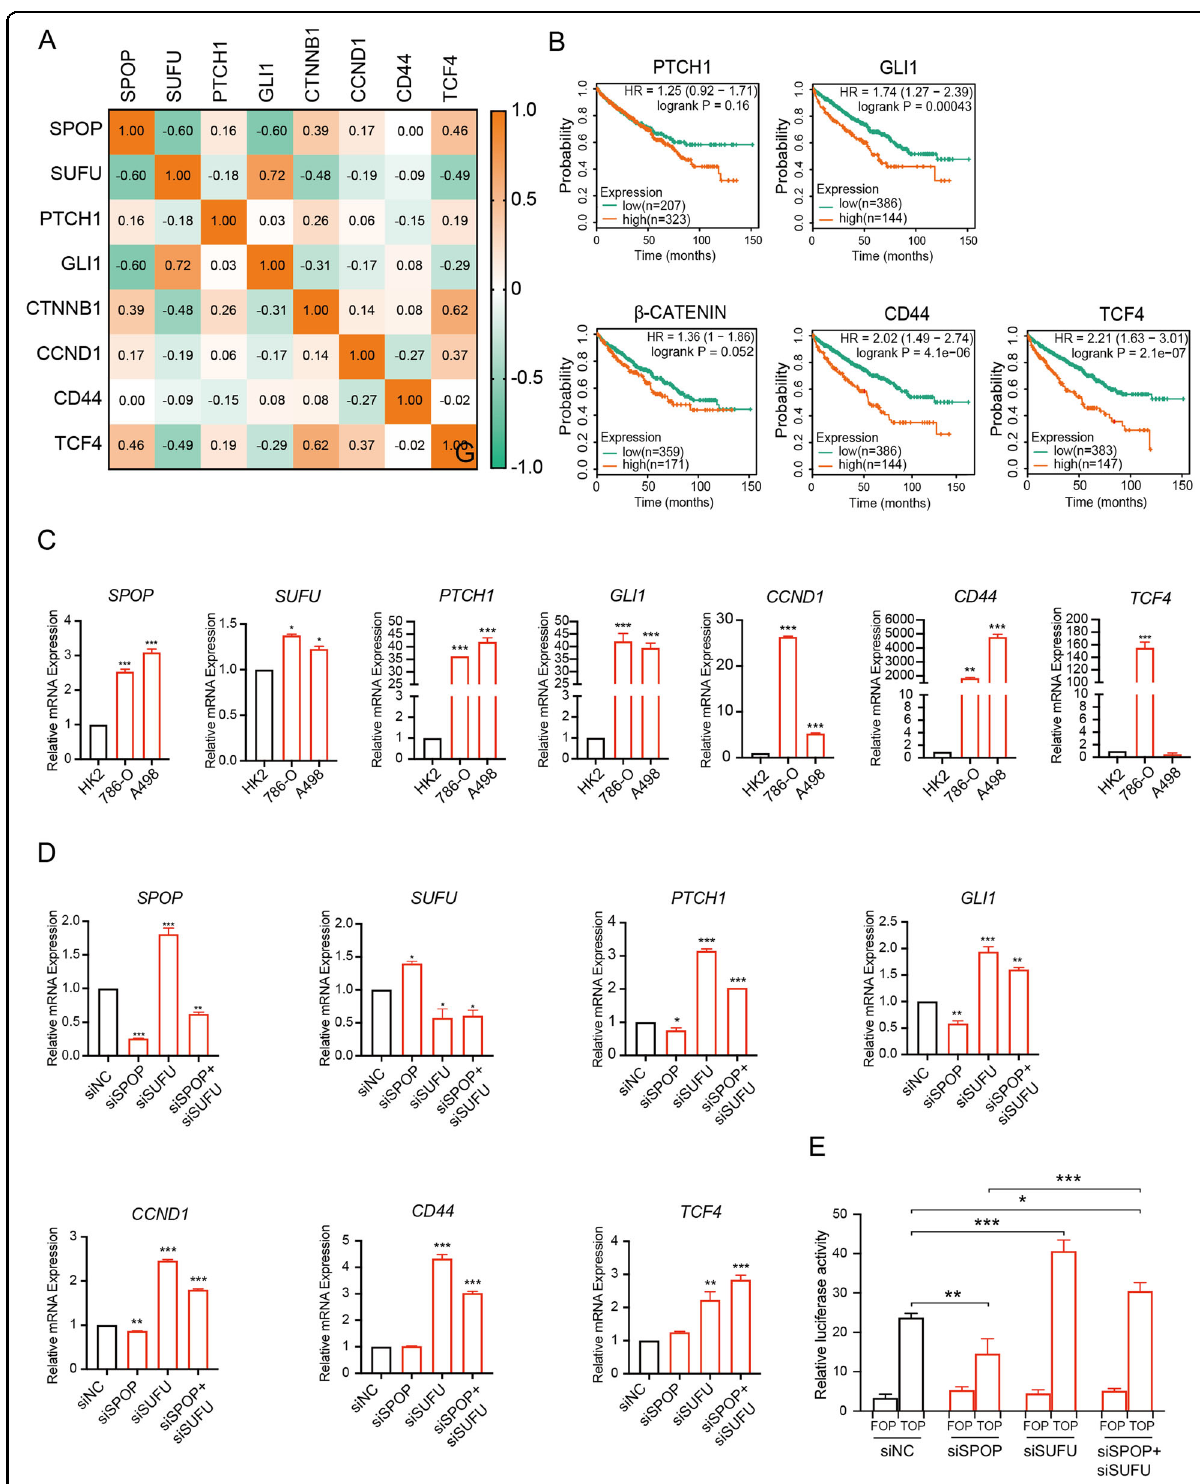
Fig. 6 SPOP promotes tumor progression via activation of the SUFU-dependent SHH and WNT signaling pathways in ccRCC. A GEO analysis of 265 ccRCC samples (GSE73731) showed the correlations among the mRNA expression of SPOP, SUFU, and the target genes of SHH and WNT signaling pathways. B Kaplan – Meier analyses showed the associations between GLI1, PTCH1, β -CATENIN, CD44, and TCF4 expression and survival in patients with ccRCC. C qRT-PCR analysis was performed to evaluate the mRNA levels of SPOP , SUFU , and SHH target genes — GLI1 , PTCH1 , and WNT target genes — CCND1 , CD44 , TCF4 . D Transcriptional levels of SPOP , SUFU , GLI1 , PTCH1 , CCND1 , CD44 , and TCF4 were examined by qRT-PCR. E TOP- fl ash and FOP- fl ash reporter activities in controls cells and cells transfected with siRNA were shown. * P <0.05; ** P <0.01; *** P <0.001 (unpaired Student ’ s t